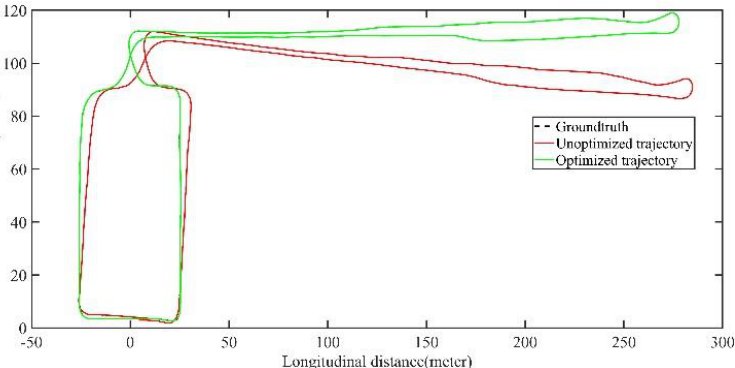
Figure 15. The comparison of trajectory before and after optimization with groundtruth of large scale scenario.